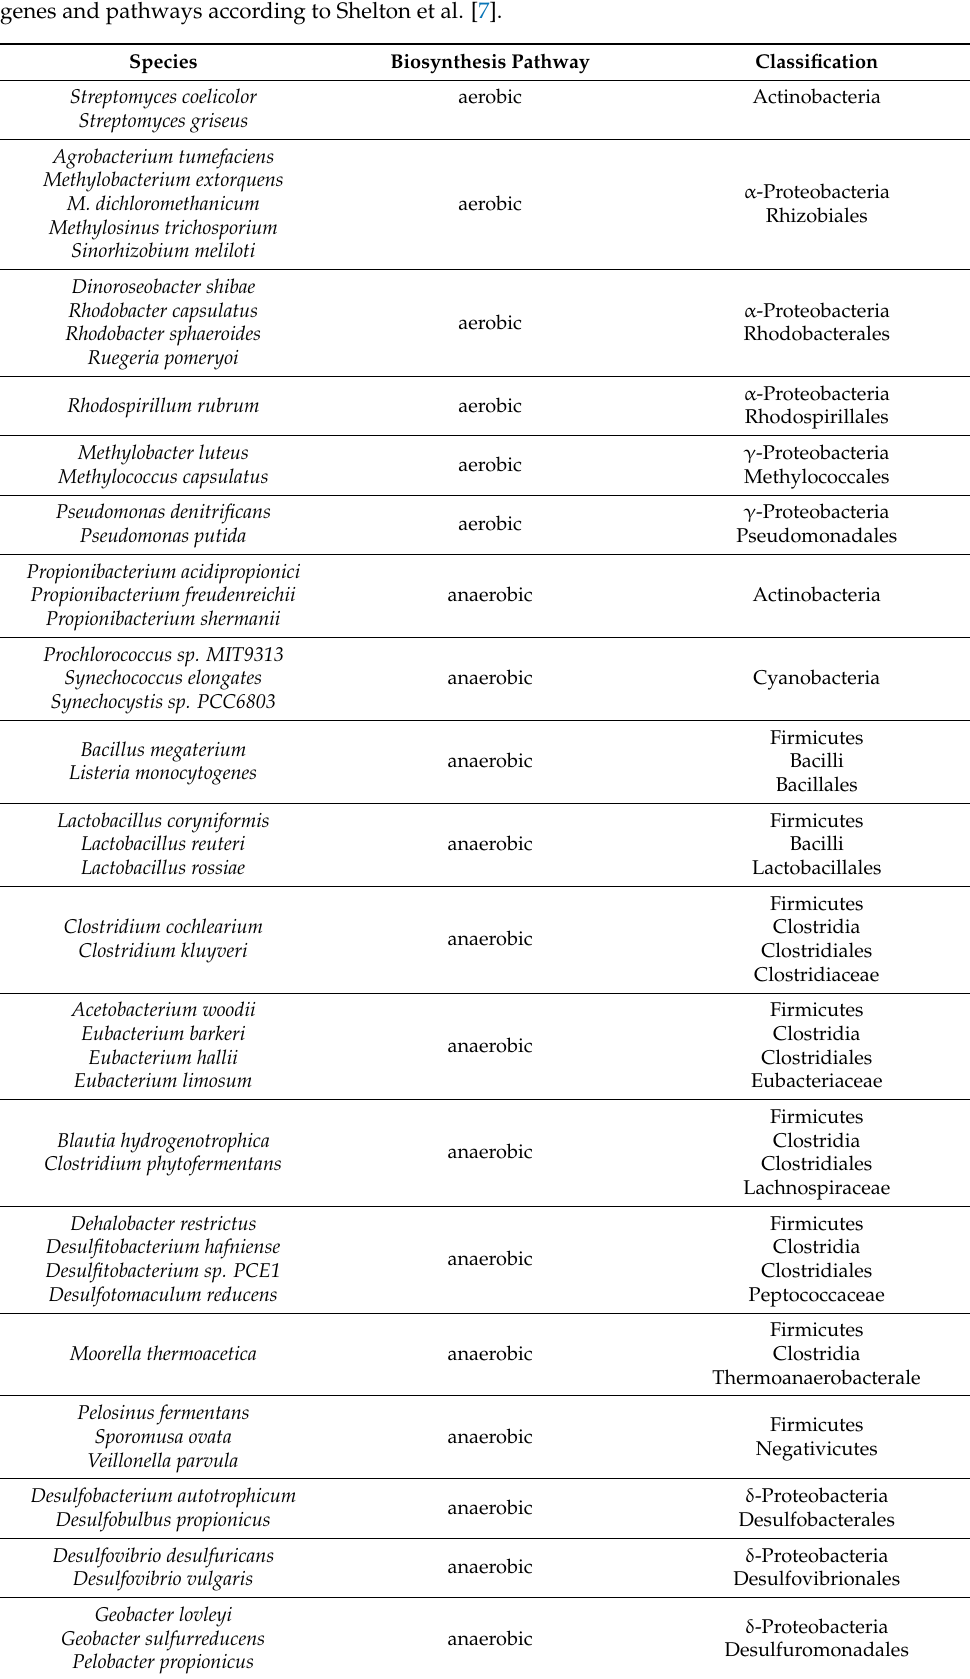
Table A2. Actively cobamide-producing microorganisms with the identified cobamide biosynthesis genes and pathways according to Shelton et al.